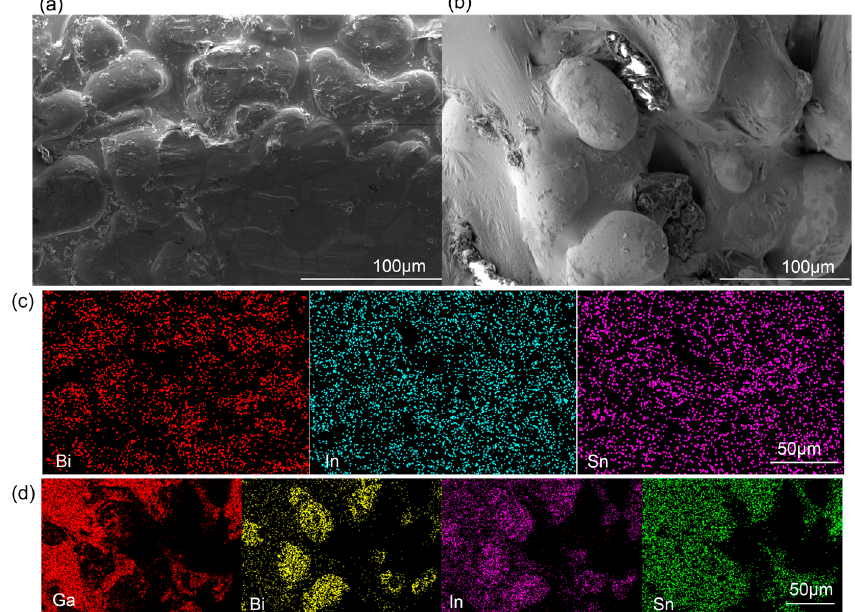
Figure 5. Electron microscopic structure of the BiInSn electrode ( a ) before and ( b ) after the introduction of the GaIn; elemental distribution of the BiInSn electrode ( c ) before and ( d ) after the introduction of the GaIn.